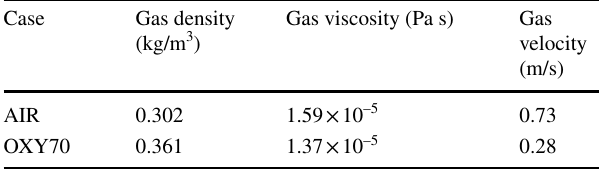
Table 4 Parameters used for estimating Stk (Eq. (4)) and η impaction (Eq. (6)) when using the plug flow assumption (Ash density: 1300 kg/ m 3 )